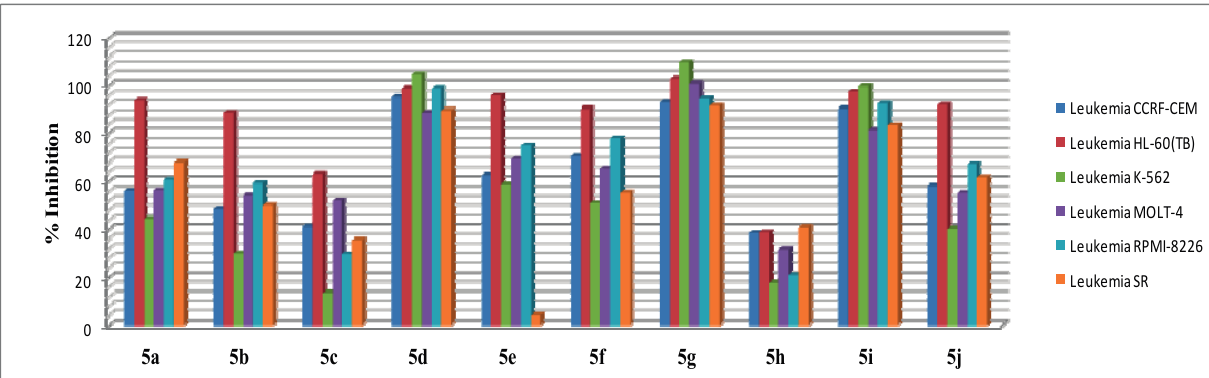
Figure 1. Inhibitory effects of compound 5c at 10 uM concentration over 60 cell lines.